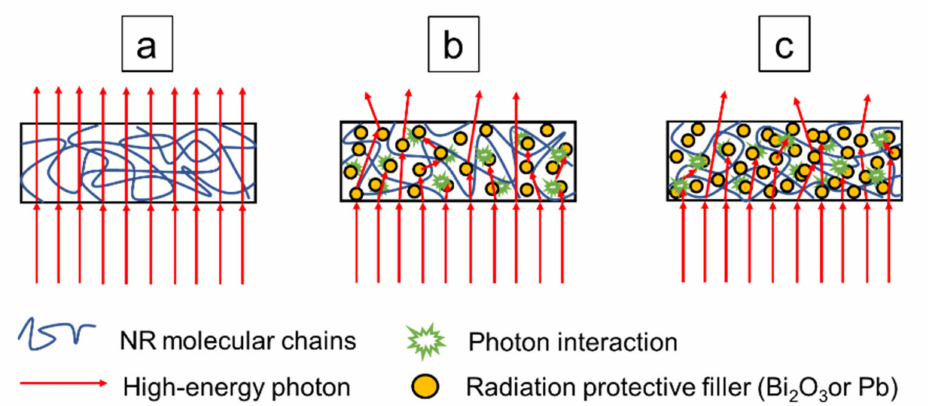
Figure 5. Scheme showing interactions of incident photons and NR composites for ( a ) a pristine NR, ( b ) and ( c ) NR composites containing radiation protective fillers (filler contents of ( c ) greater than ( b